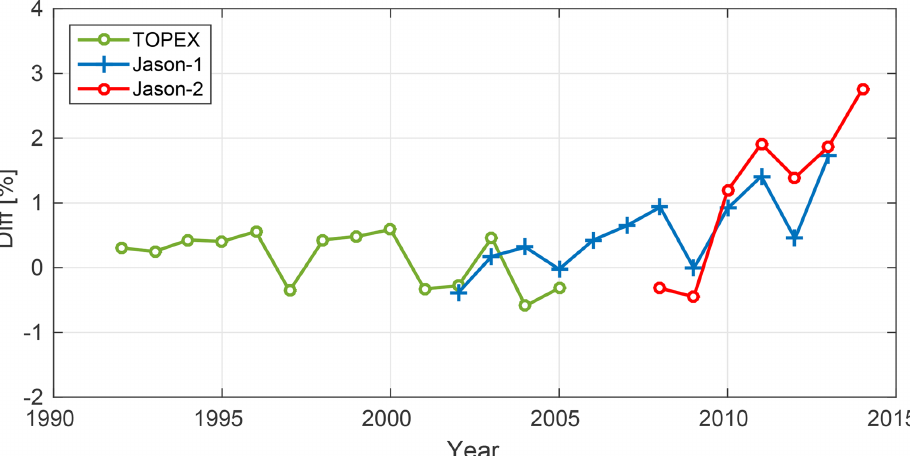
Figure 4. Relative difference (VER11-VER13) in the standard deviation of radial errors per year for three missions: TOPEX (green), Jason-1 (blue), and Jason-2 (red). Positive values indicate improvements for orbits based on